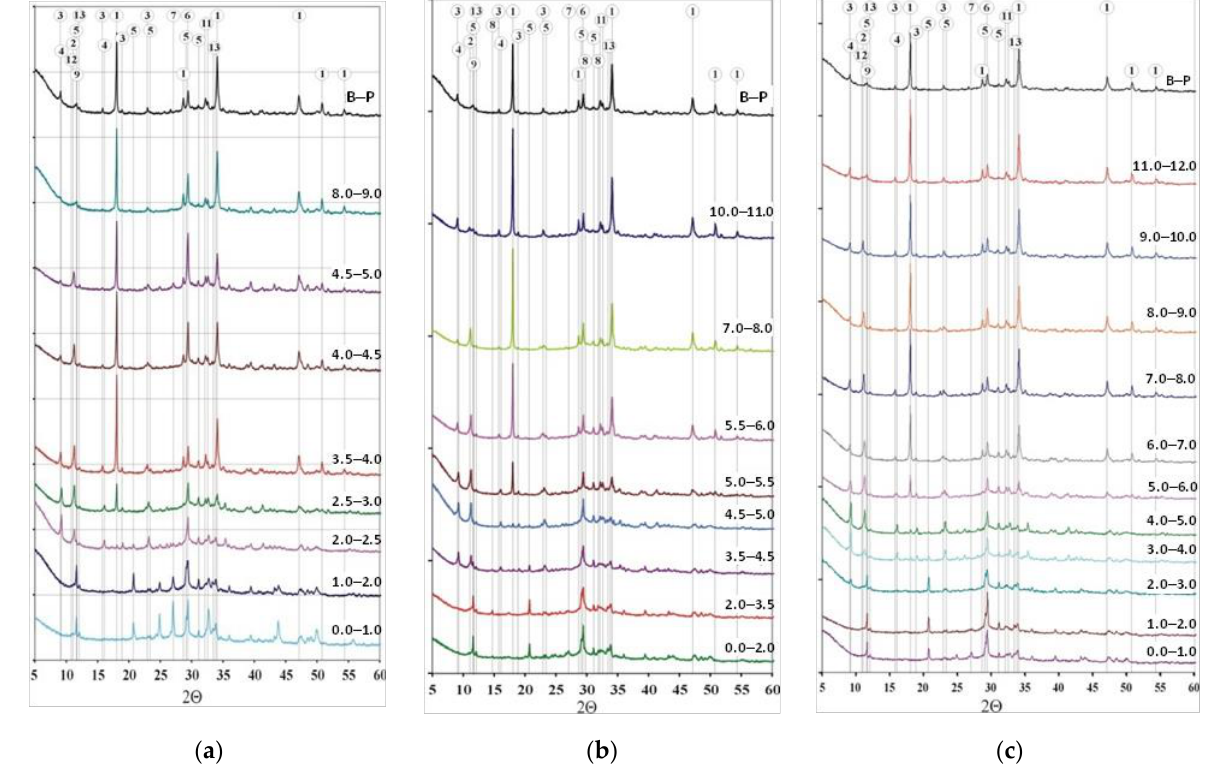
Figure 7. XRD patterns of ( a ) B-4, ( b ) B-19 and ( c ) B-25 specimen. Explanations in the text.